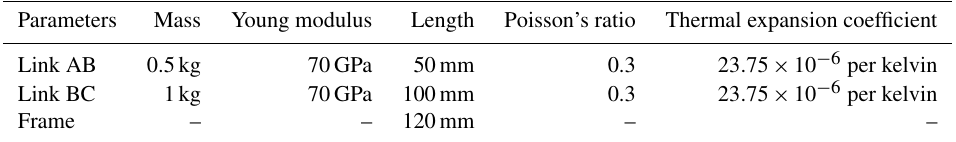
Table 2. Geometric and material parameters of deployable structure.